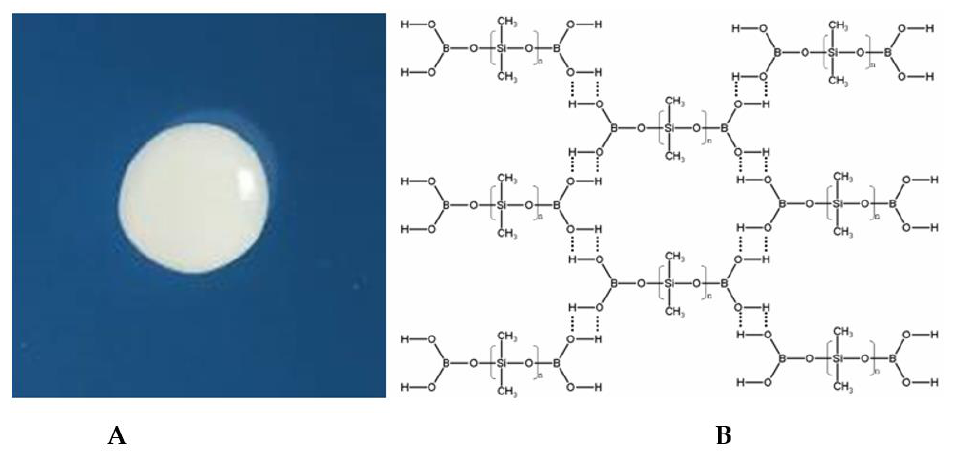
Figure 4. ( A ) — Photo of the BS, ( B ) — representation of the BS structure. Hydrogen bonds are indicated by dotted line.